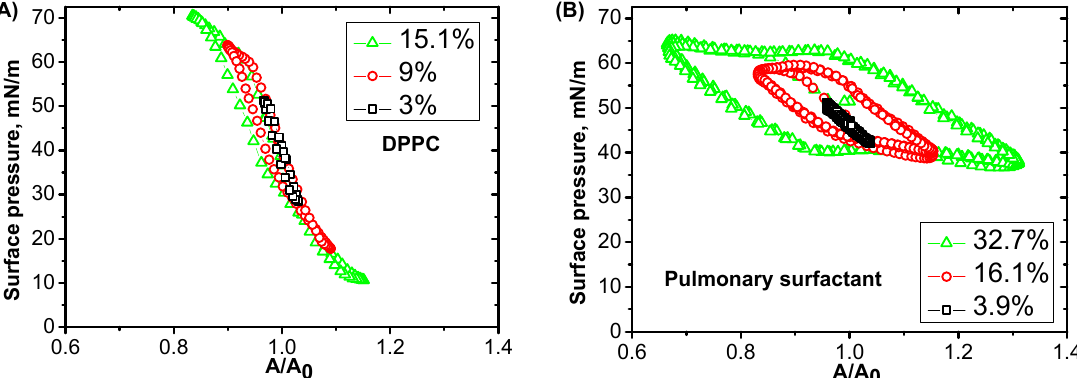
Figure 8. The dependencies of the surface pressure on the relative deformation A/A0 (Lissajous plots) measured at different amplitudes of the area oscillations, as indicated in the figure, for a spread monolayer of DPPC ( A ) and adsorbed layers of pulmonary surfactant solution at a concentration of 1.25 mg/mL at 25 °C ( B ).